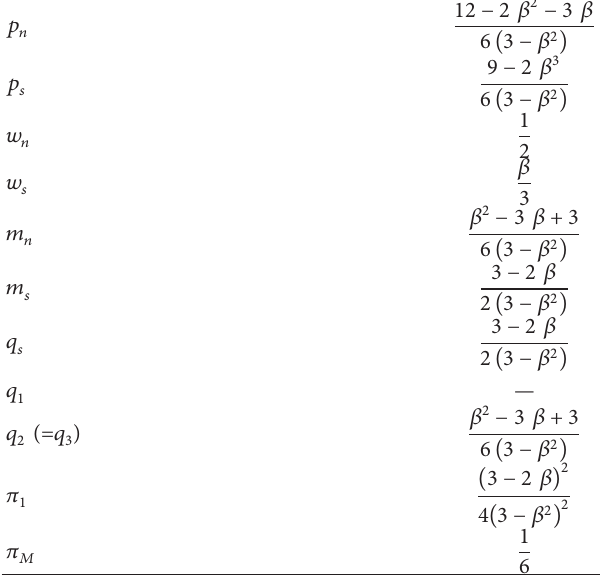
Table 6: Equilibrium outcome under ARM scenario with assort- ment S.